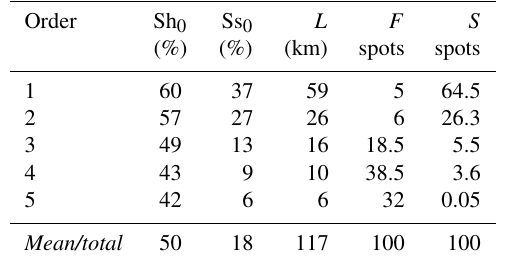
Table 5. Channel and flooded cell percentage summary. Sh 0 and Ss 0 correspond to the mean hill and stream slope, respectively. L corresponds to the total channel length. F spots and S spots cor- respond to the flooded and slide percentages,